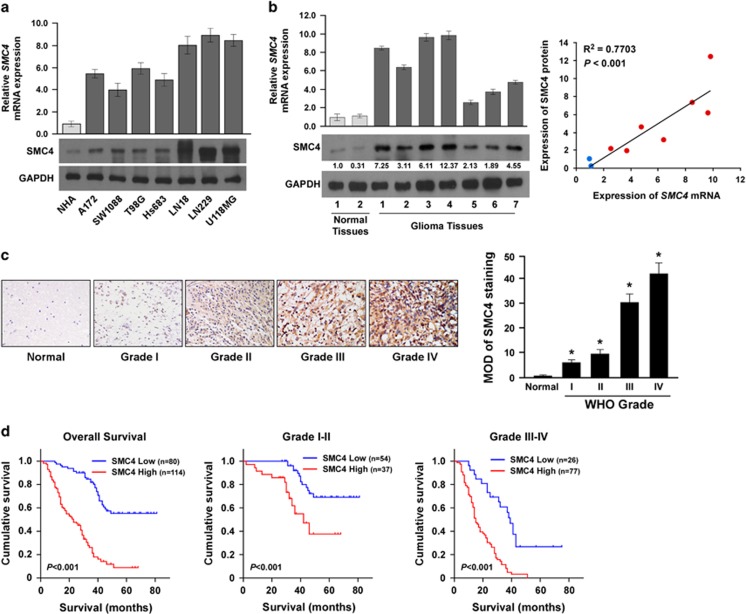
SMC4 protein overexpression correlates with poor prognosis in human glioma. (a) Real-time reverse transcription–PCR (RT-PCR) and western blot detection of SMC4 mRNA and protein expression in NHA and cultured glioma cell lines (A172, SW1088, T98G, Hs683, LN18, LN229 and U118MG). (b) Real-time RT-PCR and western blot detection of SMC4 mRNA and protein expression in two normal brain tissue samples and seven glioma tissue samples (left). The Spearman correlation coefficient was calculated to assess the significance of association between SMC4 mRNA and protein expression levels (right, P<0.001). (c) IHC analysis of SMC4 protein expression in 194 glioma specimens of different WHO grades (left), magnification, × 400. Statistical quantification of the average mean optical densities (MODs) of SMC4 staining of 194 glioma specimens of different WHO grades (right). (d) Kaplan–Meier analysis of SMC4 expression levels in WHO grades I–IV gliomas and patient survival. *P<0.05.